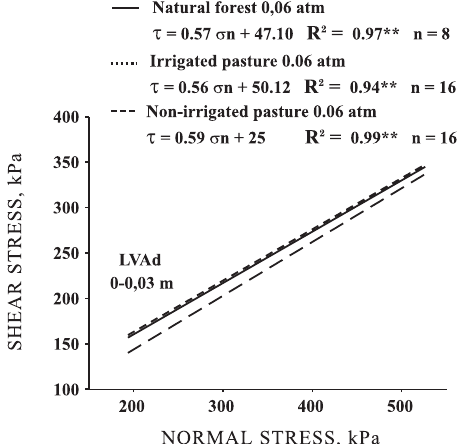
Figure 2. Shear rupture lines of an LVAd submitted to different managements, with samples at a water tension of Table 1. Water-physical characterization and organic matter of the Red-Yellow Latosol (LVAd) under different managements and uses in the 0–0.03 m layer